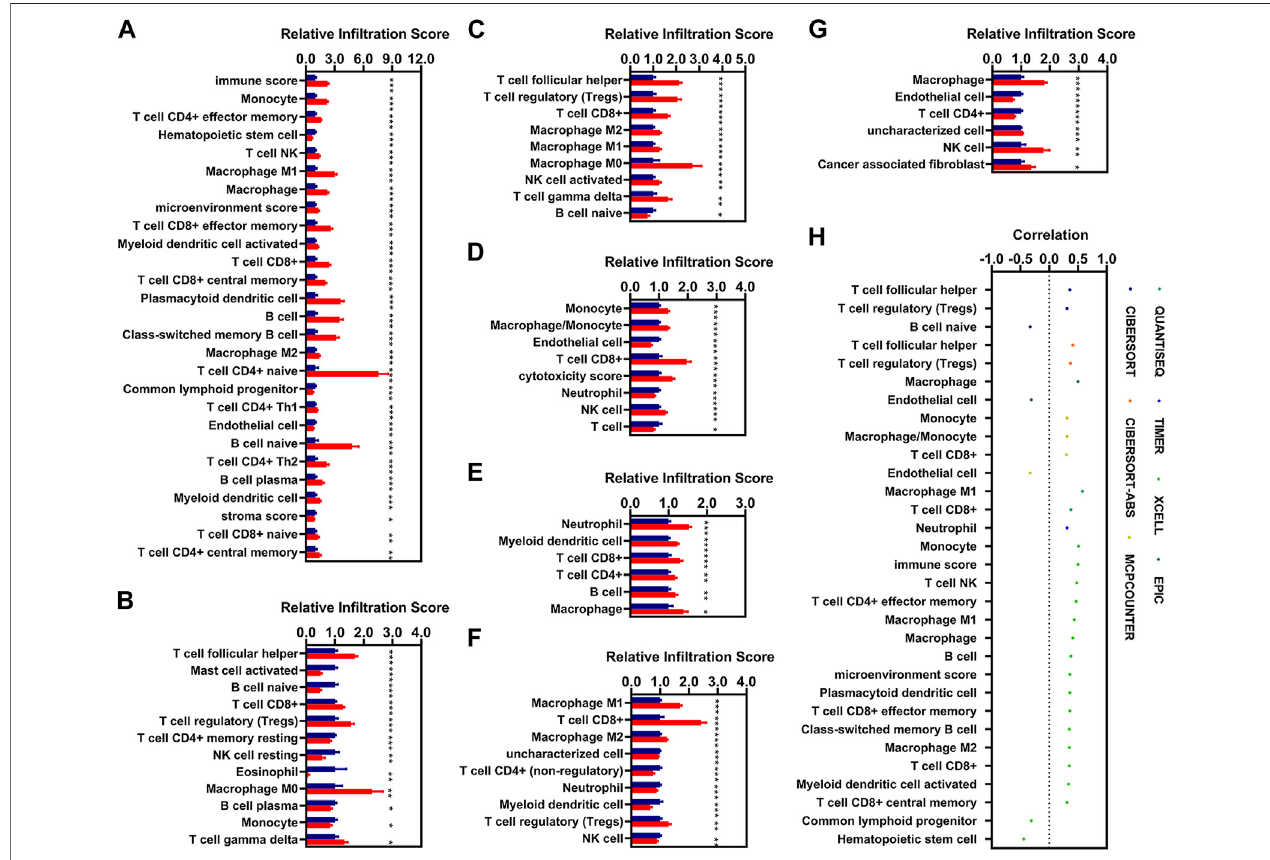
FIGURE6| Correlationsanalysisofriskscoreswithimmune in fi ltration. (A – G) ,Theexpression oftheimmune cellsandfactors withtheriskmodel[ (A) ,XCELL. (B) , CIBERSORT. (C) ,CIBERSORT-ABS. (D) ,MCPCOUNTER. (E) ,TIMER. (F) ,QUANTISEQ. (G) ,EPIC). (H) ,Correlationoftheriskmodelswith31immunecellsandfactors (|R| > 0.3, p < 0.05). * means p < 0.05, ** means p < 0.01, *** means p <